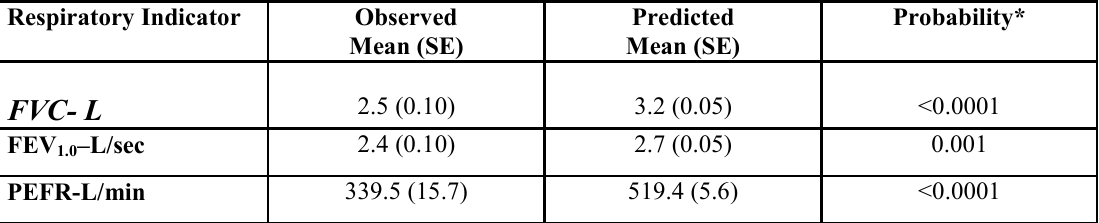
Table 3 - Comparison of pulmonary function with predicted values of granite workers (n=51)